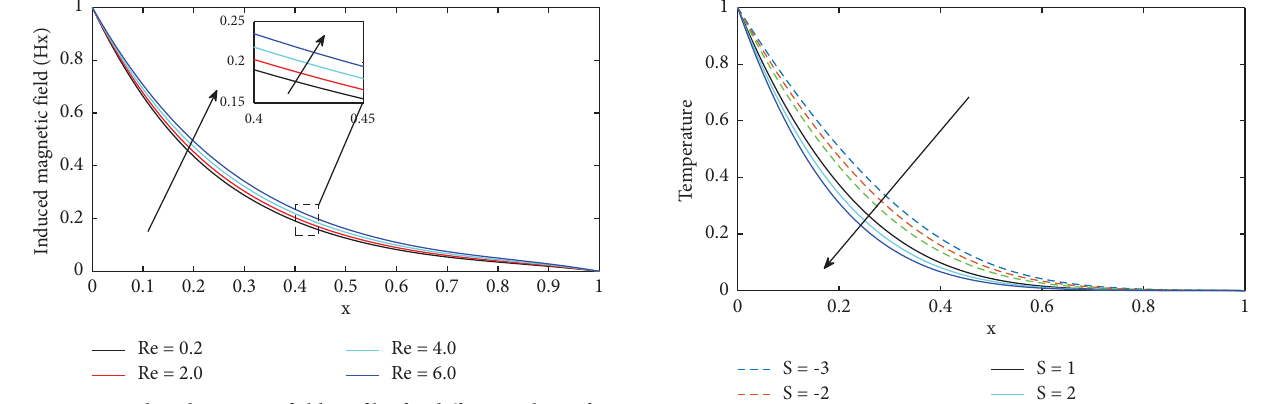
Figure 15: Induced magnetic feld profles for diferent values of Re .